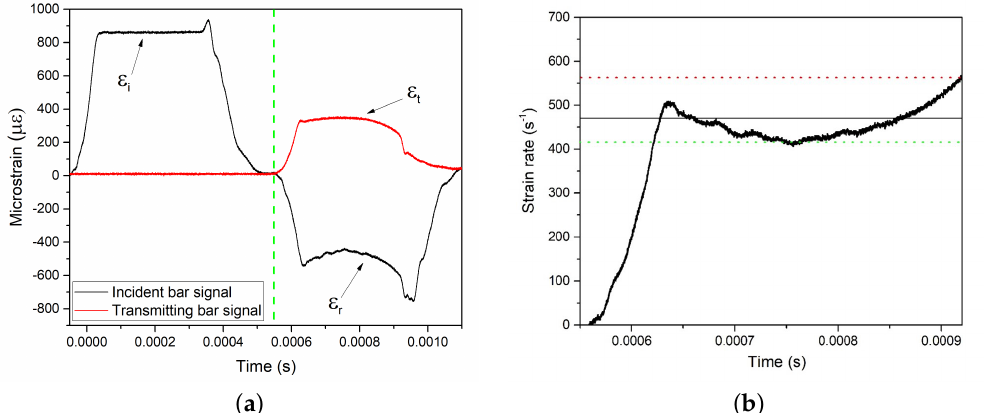
Figure 4. Hopkinson bar experiment output in terms of incident, transmitted and reflected stress waves ( a ), and the actual strain-rate over the test ( b ).